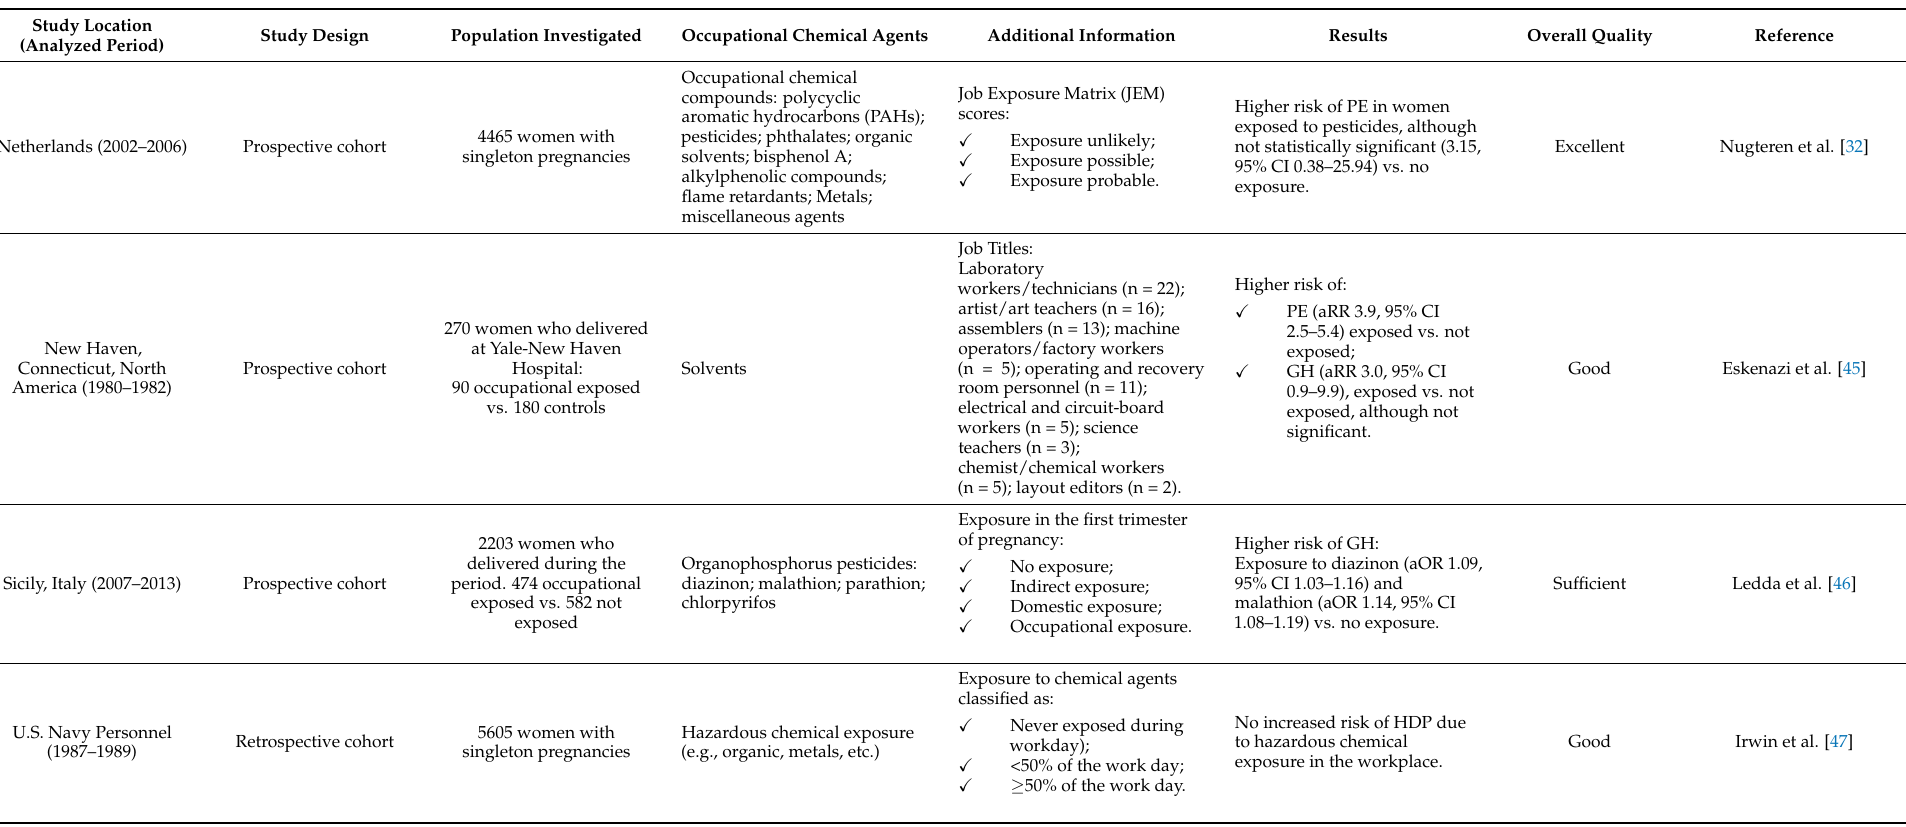
Table 2. Studies assessing the relationship between hypertensive disorders in pregnancy (HDP), including preeclampsia (PE) and gestational hypertension (GH), and exposure to chemical risk